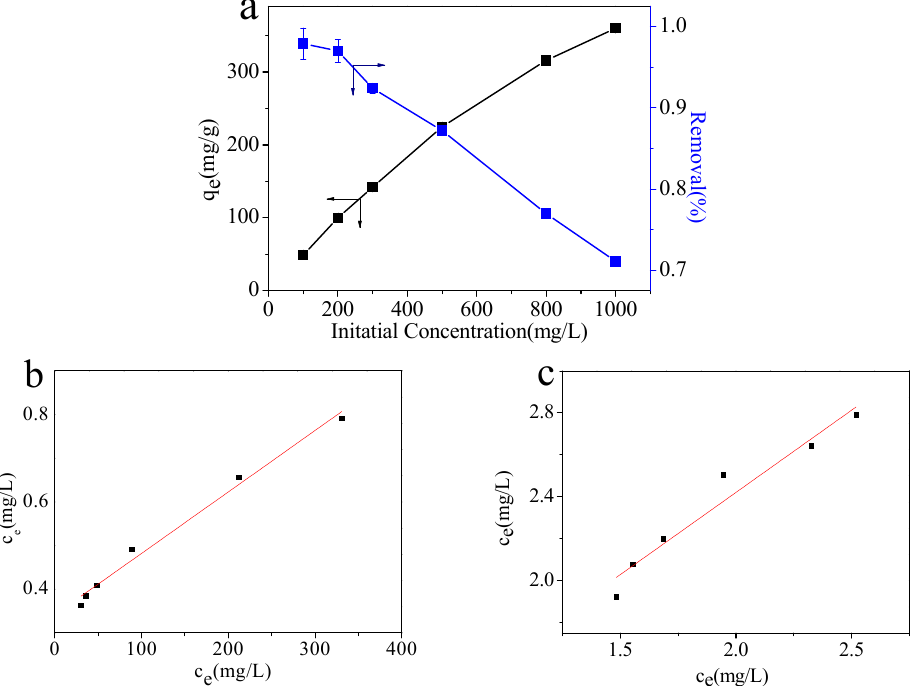
Figure 8. ( a ) The impact of initial Pb(II)-solution concentration ( C 0 ) on the adsorption capacity of the MIL-125-CS beads. Linear fits to the ( b ) Langmuir and ( c ) Freundlich isotherm models.